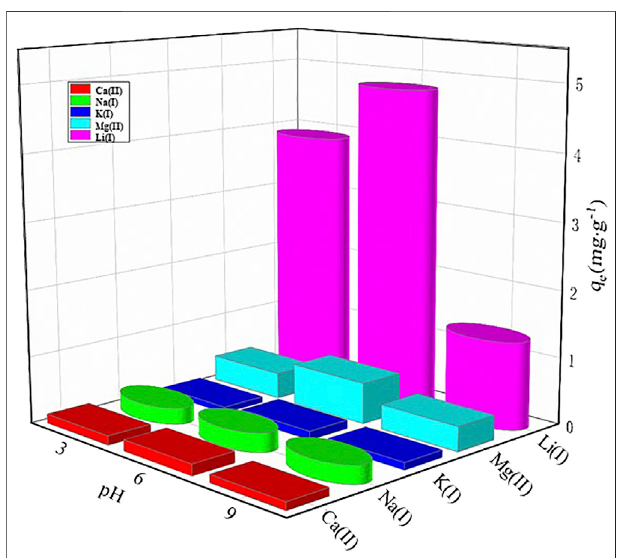
TABLE 3 | Adsorption performance of adsorbents for Li(I) in studies. Adsorbent Adsorption equilibrium time